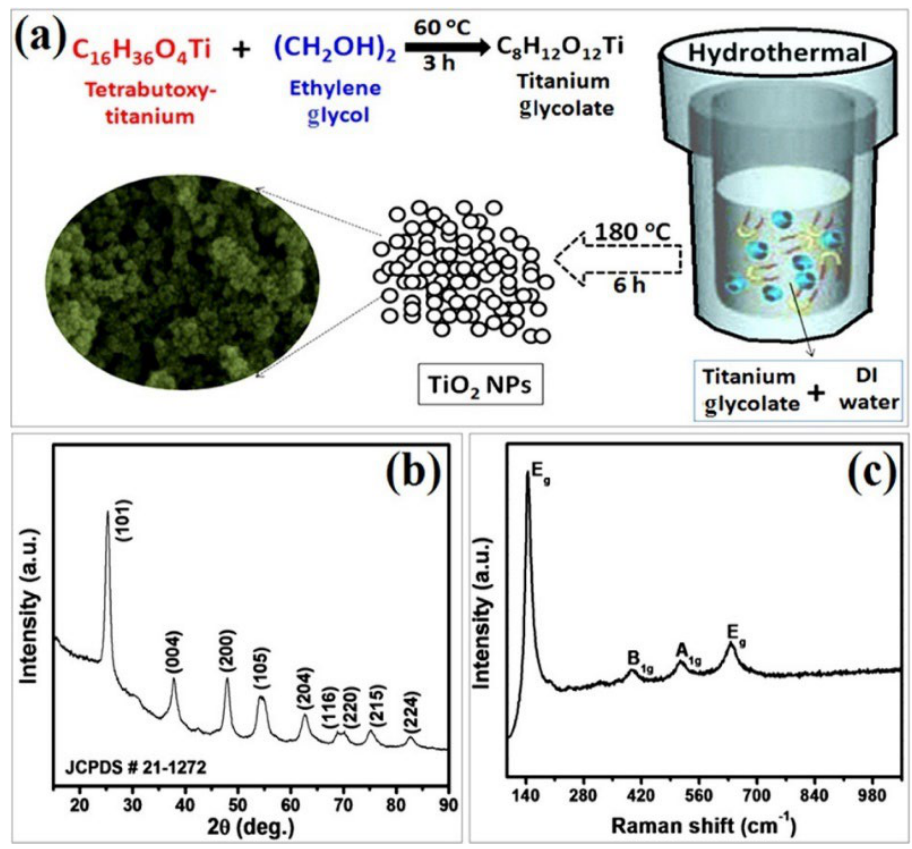
Figure 21. Synthesis and characterization of synthesized anatase TiO 2 NPs: ( a ) synthesis scheme, ( b ) XRD, and ( c ) Raman spectrum of TiO 2 . Reprinted from [81].